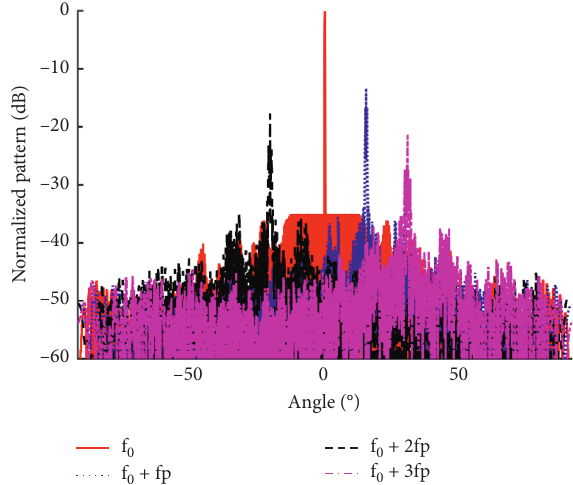
Figure 11: Max SBL from the second sideband to the 15 th sideband of different beamforming directions. Table 4: Comparison of optimization results under different θ